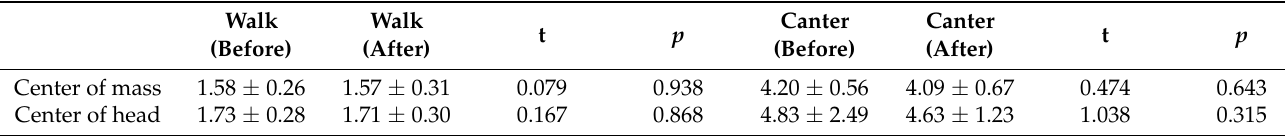
Table 3. The center of mass and the center of head velocities. Unit: